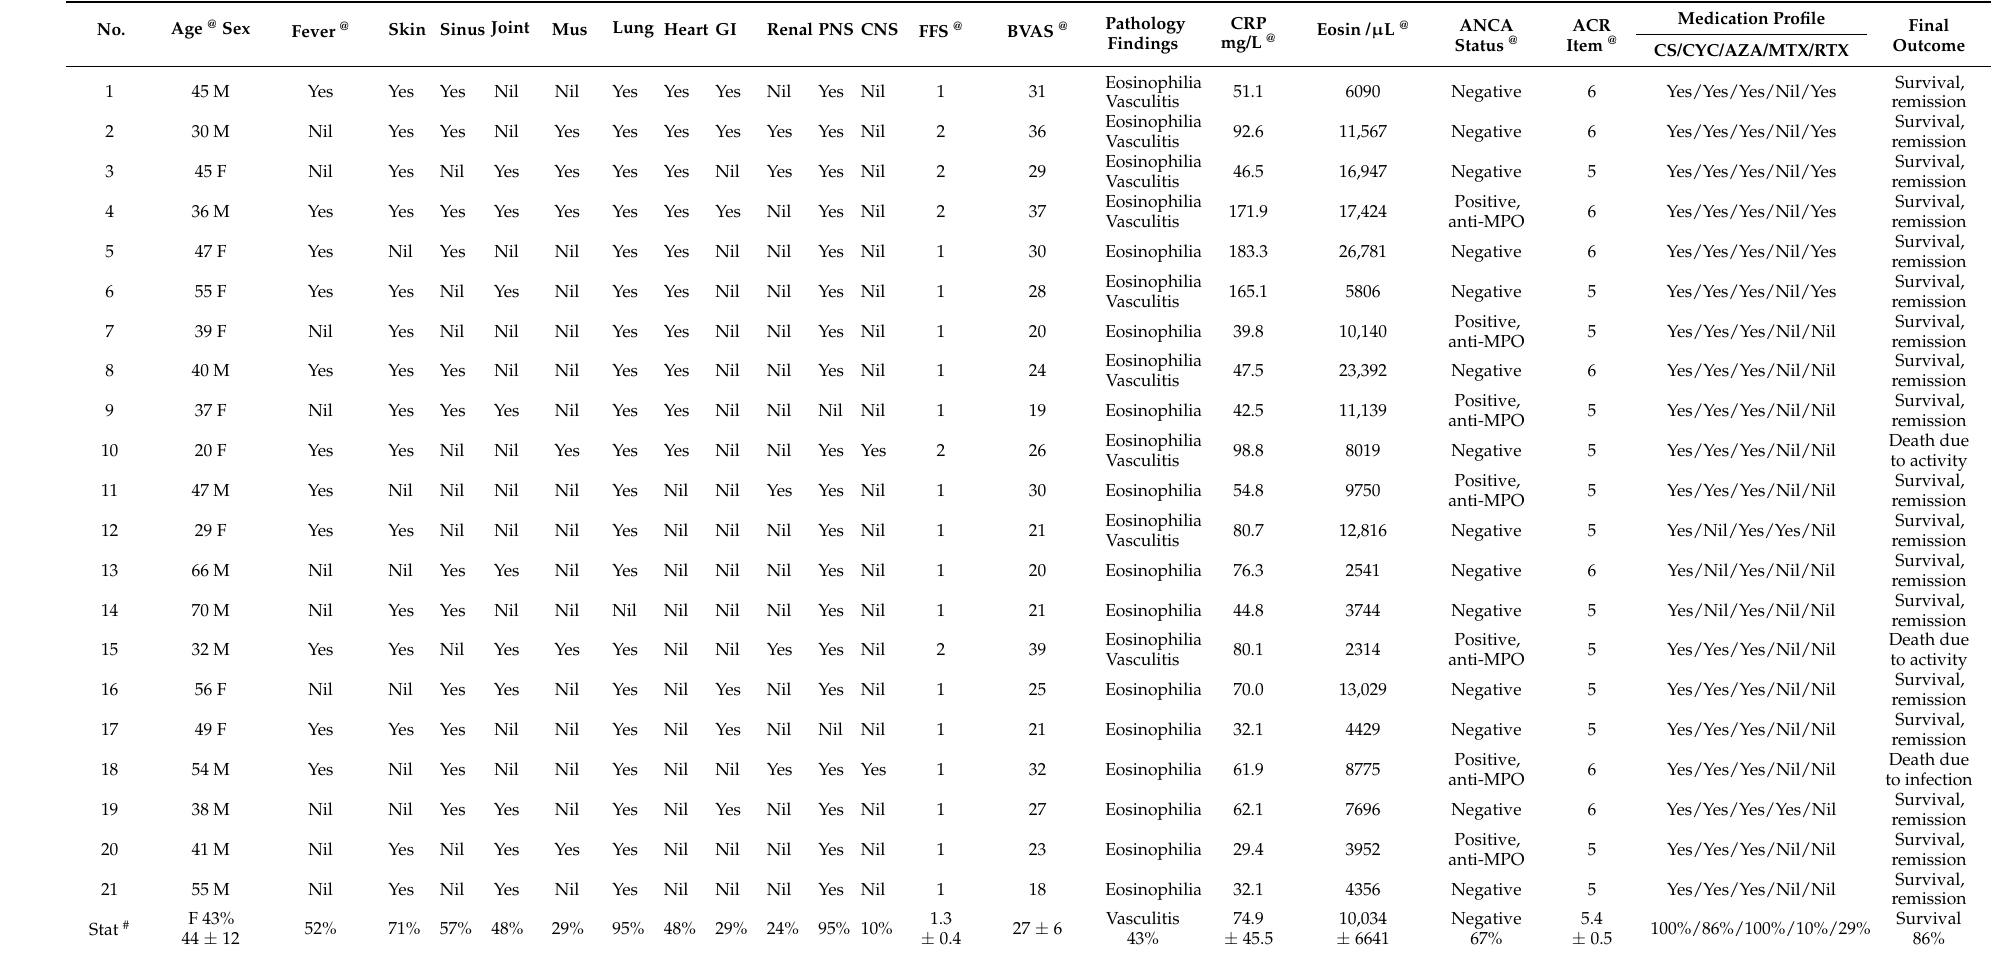
Table 1. Demographic, clinical, laboratory, pathological, medication and outcome data in 21 admitted EGPA